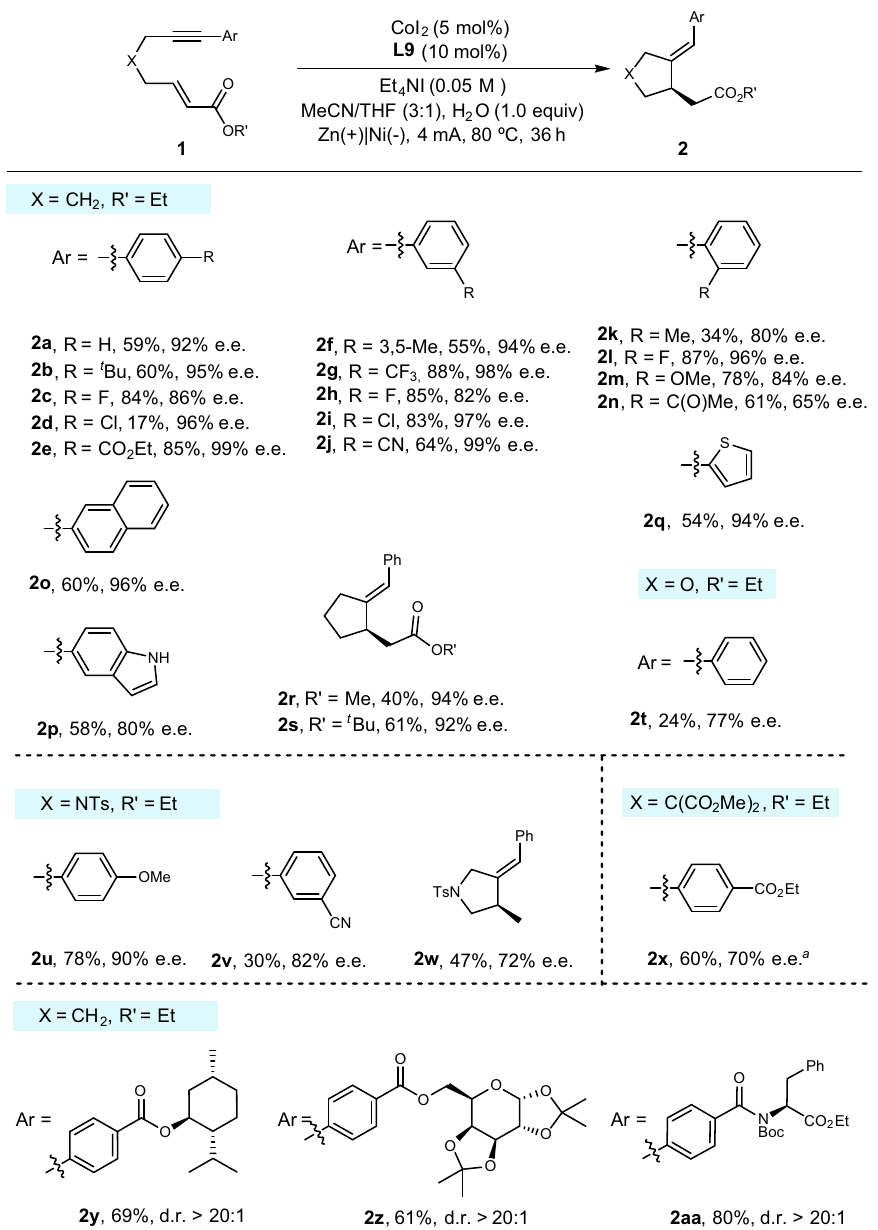
Fig. 2 | Exploration of substrate scope. The reaction was performed on a 0.4mmol scale under the conditions in Table 1, entry 1. a L8 was used as